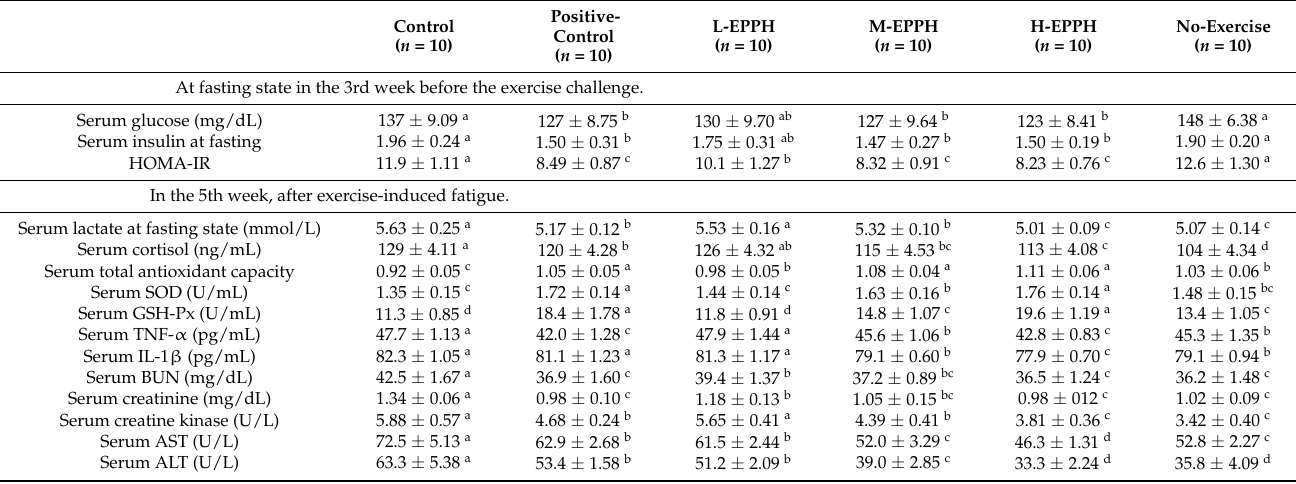
Table 3. Serum metabolic parameters related to exercise-induced fatigue at the 3rd and 5th week of the intervention. Control ( n = 10)